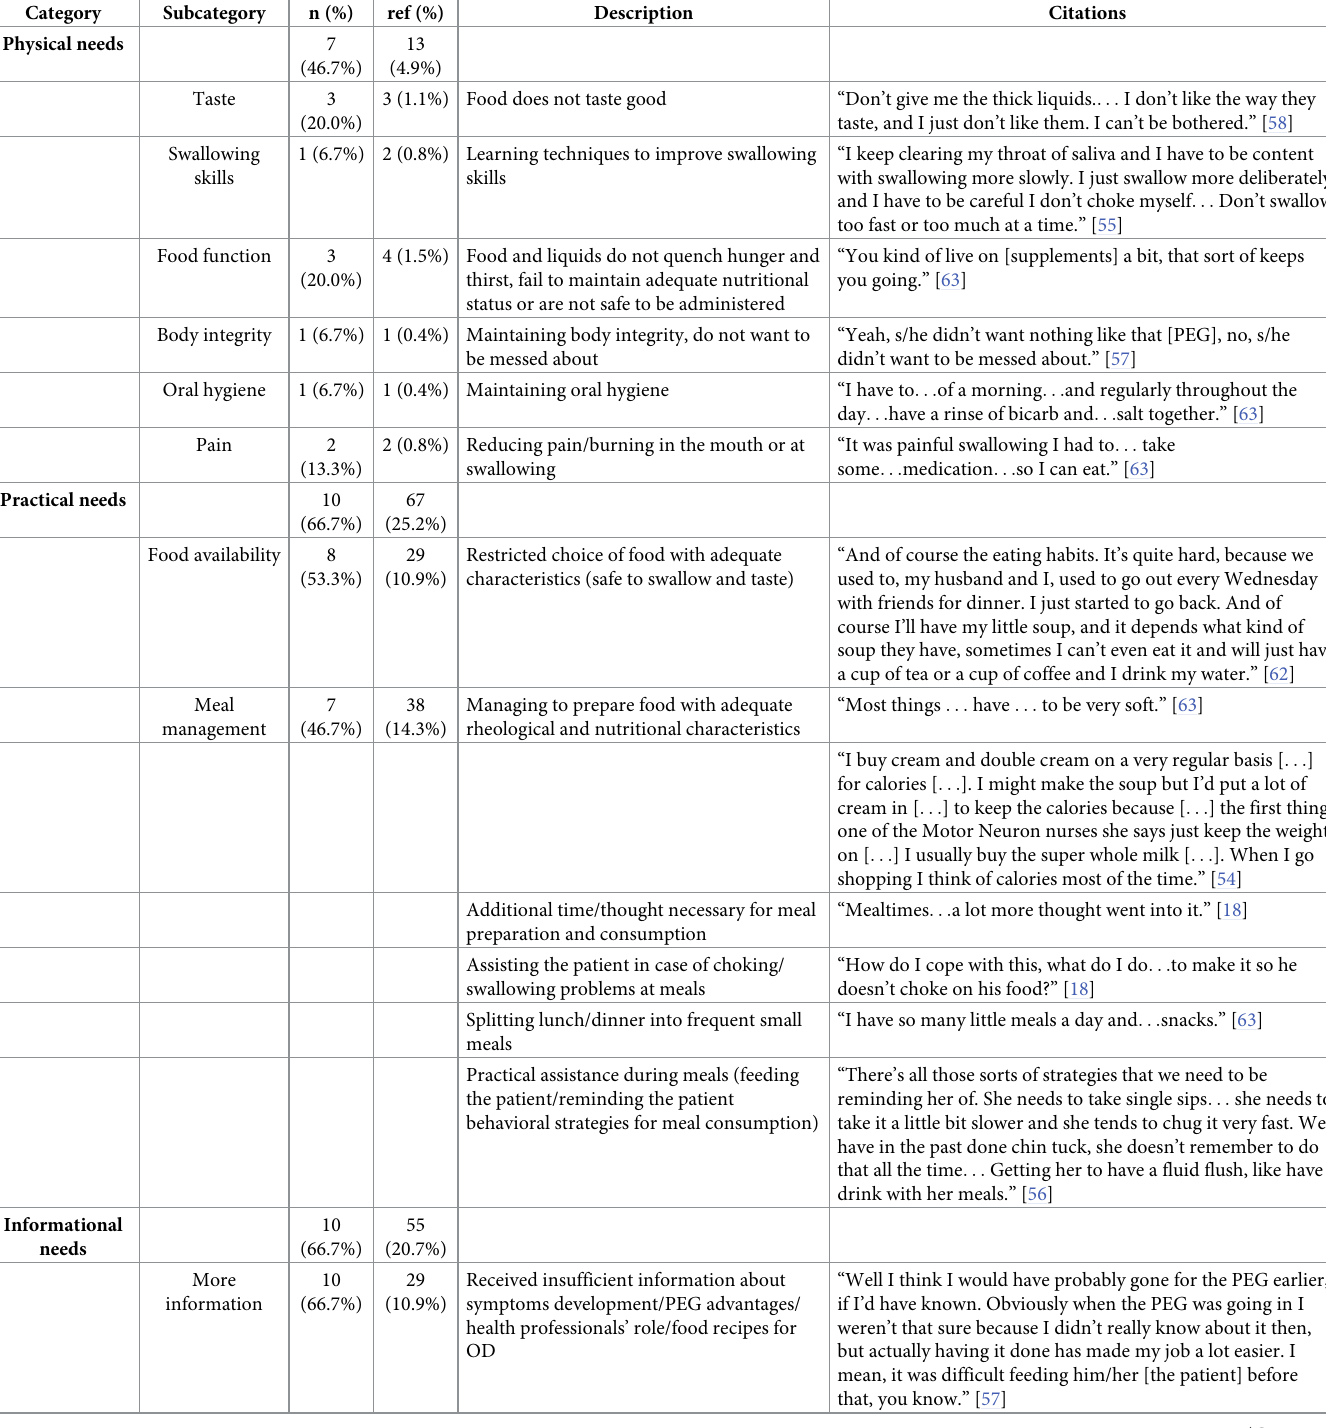
Table 3. OD-related needs classification with subcategories and exemplary citations.